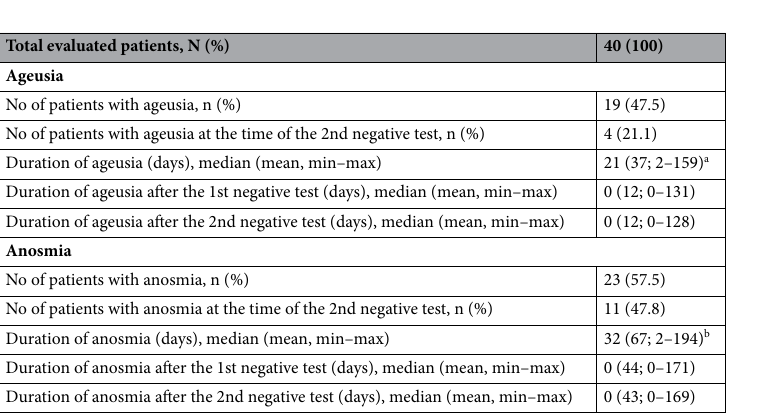
Table 7. Sensory disorders with extended follow-up in the cohort with two negative tests. a 1 patient still had ageusia at the time of follow-up (data adjusted to the date of the last follow-up—October, 31th, 2020). b 6 patients still had anosmia at the time of follow-up (data adjusted to the date of last follow-up—October, 31th, 2020).